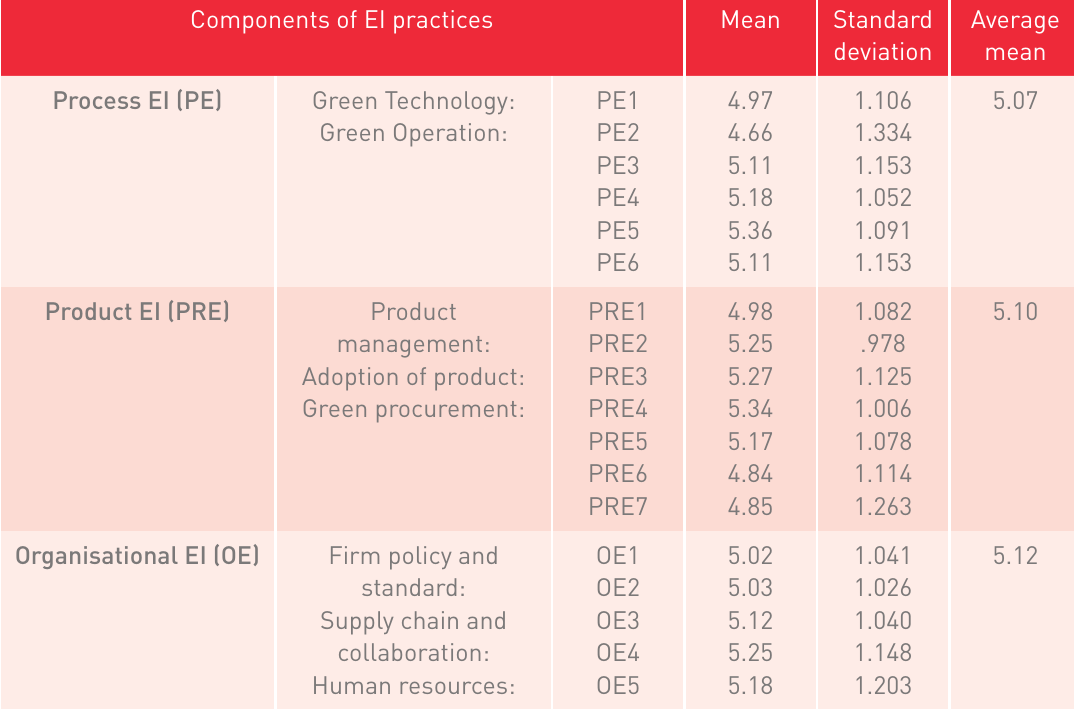
Average deviation